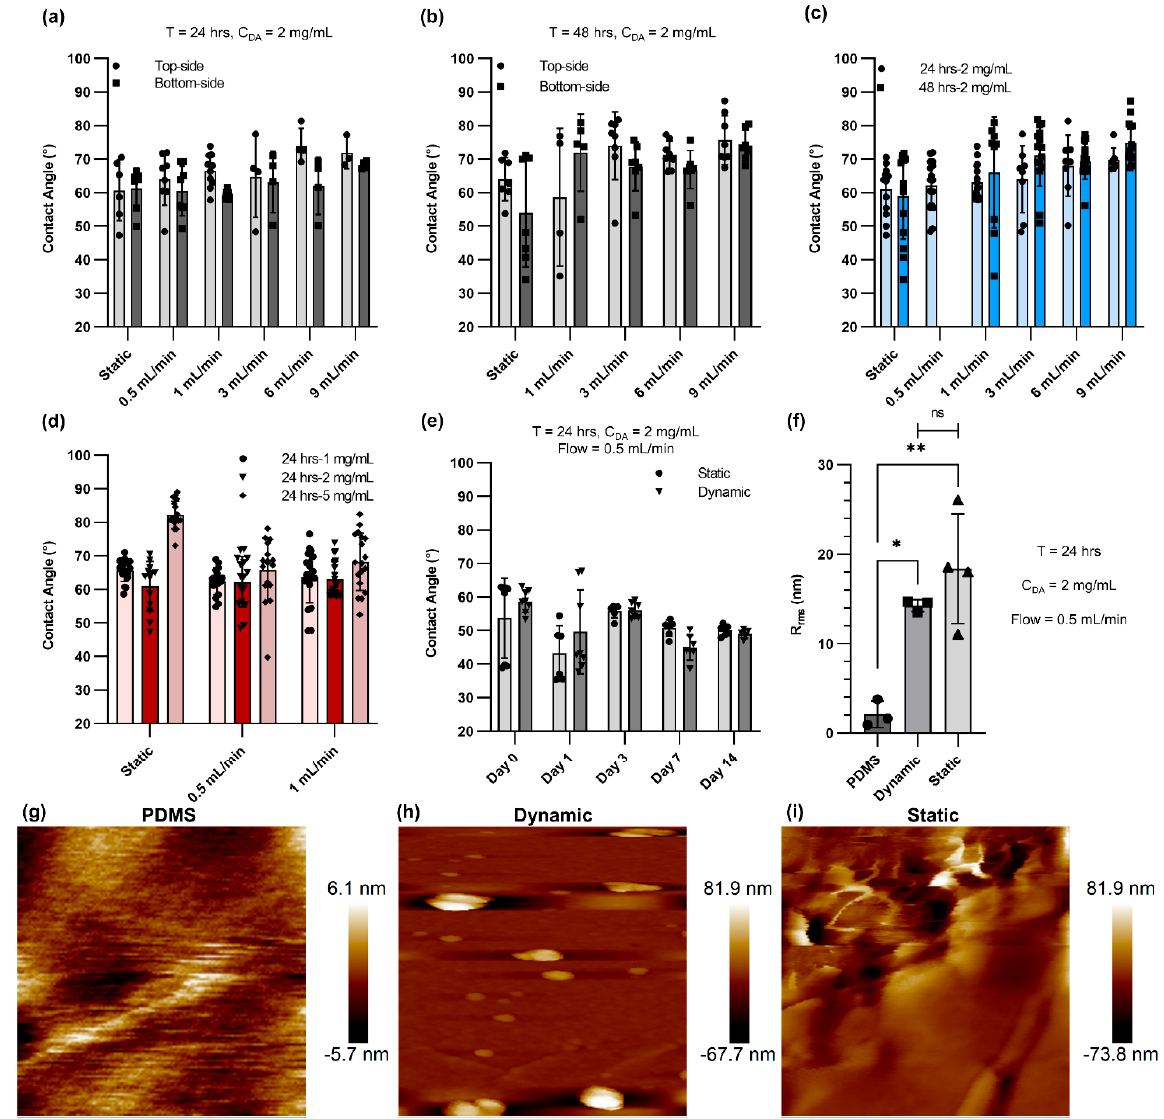
Figure 1. Characterization of PDA for microfluidic device: ( a ) Contact angle data for static PDA coating and dynamic PDA coating with different flow rates after 24 h coating with a concentration of 2 mg mL − 1 , ( b ) contact angle data for static PDA coating and dynamic PDA coating with different flow rates after 48 h coating with a concentration of 2 mg mL − 1 , ( c ) comparison of contact angle data for 24 h and 48 h coating of PDA, ( d ) the effect of DA concentration on contact angle measurement for static and dynamic coating, ( e ) contact angle data for static PDA coating and dynamic PDA coating (flow rate = 0.5 mL min − 1 ) over 14 days tested under continuous flow, ( f ) surface roughness comparison of various conditions measured by atomic force microscopy (AFM), ( g ) surface topography of a native PDMS surface, ( h ) surface topography of a PDMS surface coated with PDA using dynamic coating technique (flow rate = 0.5 mL min − 1 ), and ( i ) surface topography of a PDMS surface coated with PDA using static coating method.* p ≤ 0.05 and ** p ≤ 0.01.